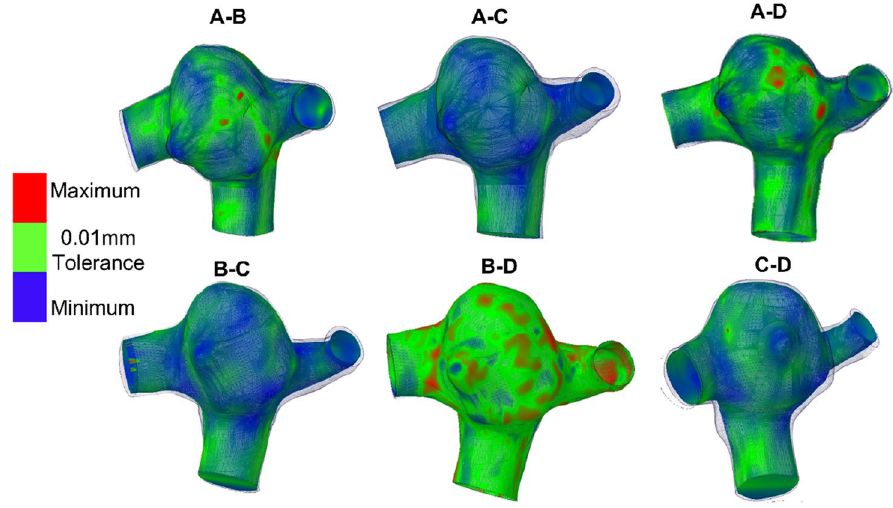
Figure 2. Contours representing the differences in surface roughness of the geometries for timepoint VI between operators. Green represents a tolerance of 0.01 mm, blue and red represent the minimum (inner tolerance, IT) and maximum variation (outer tolerance, OT) of the source geometry with respect to target geometry.